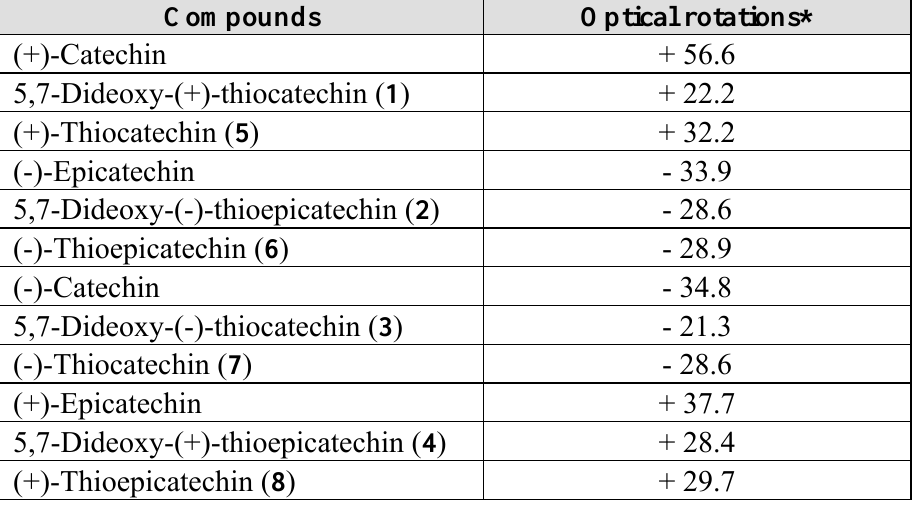
Table 1. Optical rotations of the sulfur analogues of